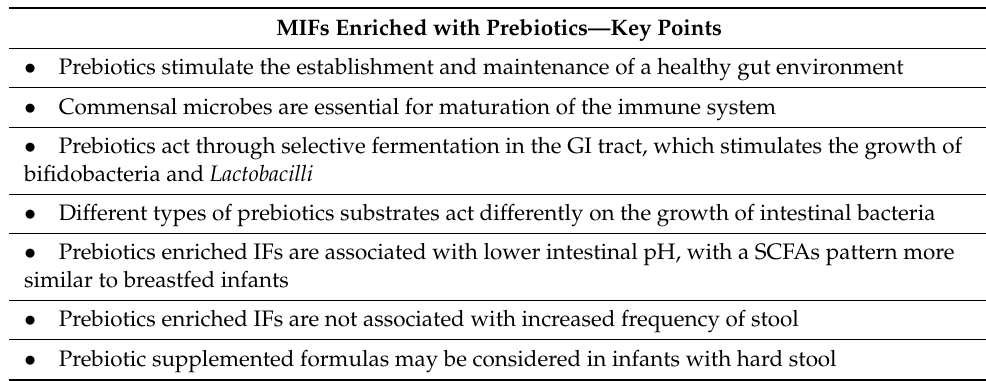
Table 3. Summary of beneficial effect of MIFs enriched with